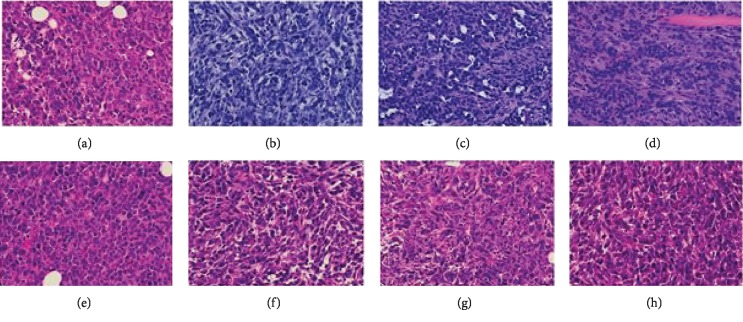
Histochemical characterization of the solid tumors formed by the parental 4T1luc2 cells (a) and their derivatives expressing variants of HIV-1 FSU_A reverse transcriptase (RT_A) after ectopic implantation into BALB/c mice: 4T1luc2_RT-1.3 (b), 4T1luc2_RT-5.3 (c), 4T1luc2_RT-20.1 (d), 4T1luc2_RT-An-1.4 (e), 4T1luc2_RT-An-10.1 (f); 4T1luc2_RT-Ann-1.5 (g), 4T1luc2_RT-Ann-10.2 (h). H&E staining: magnification ×400.